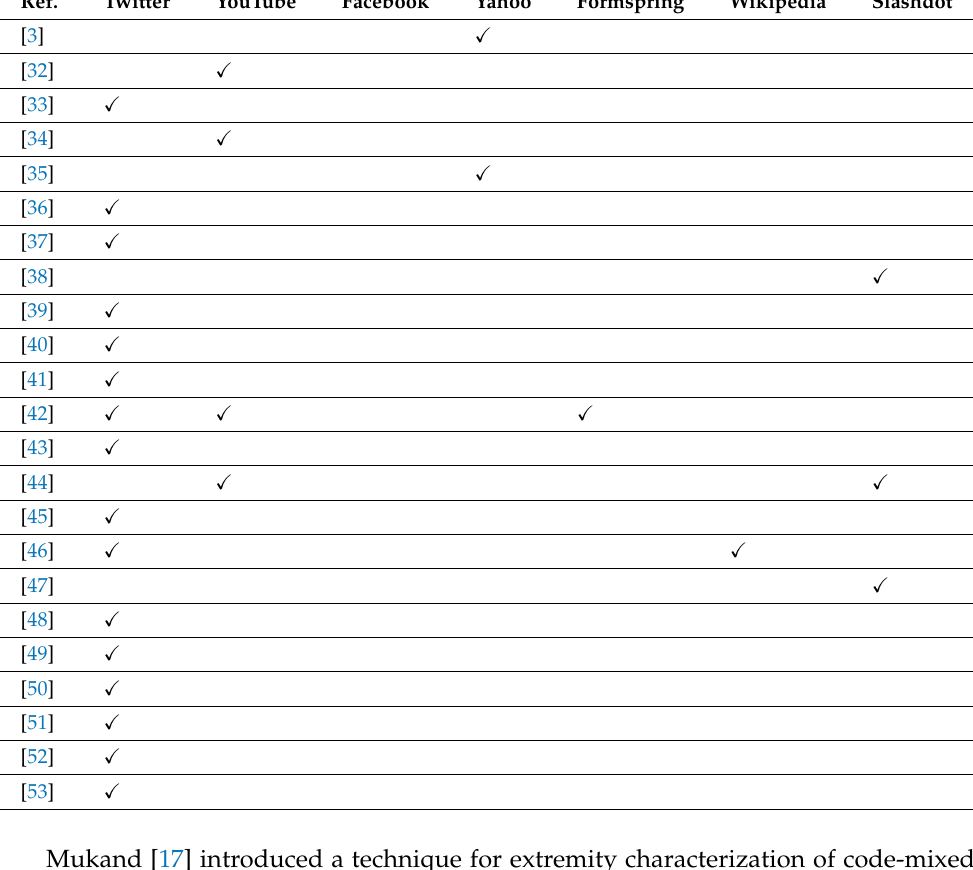
Table 2. Summary of platforms used in the collection of datasets.